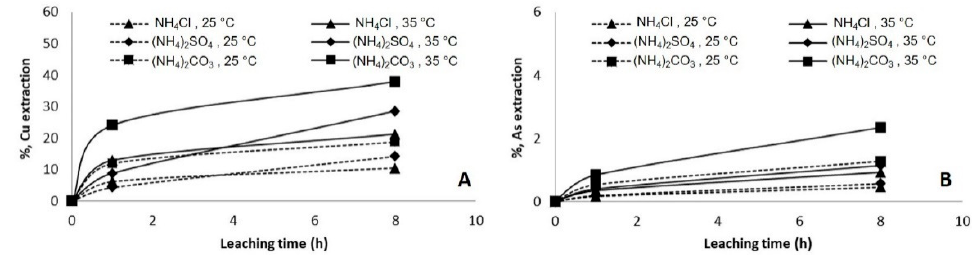
Figure 2. Copper ( A ) and arsenic ( B ) extraction in different ammonia solution at 25 °C and 35 °C.